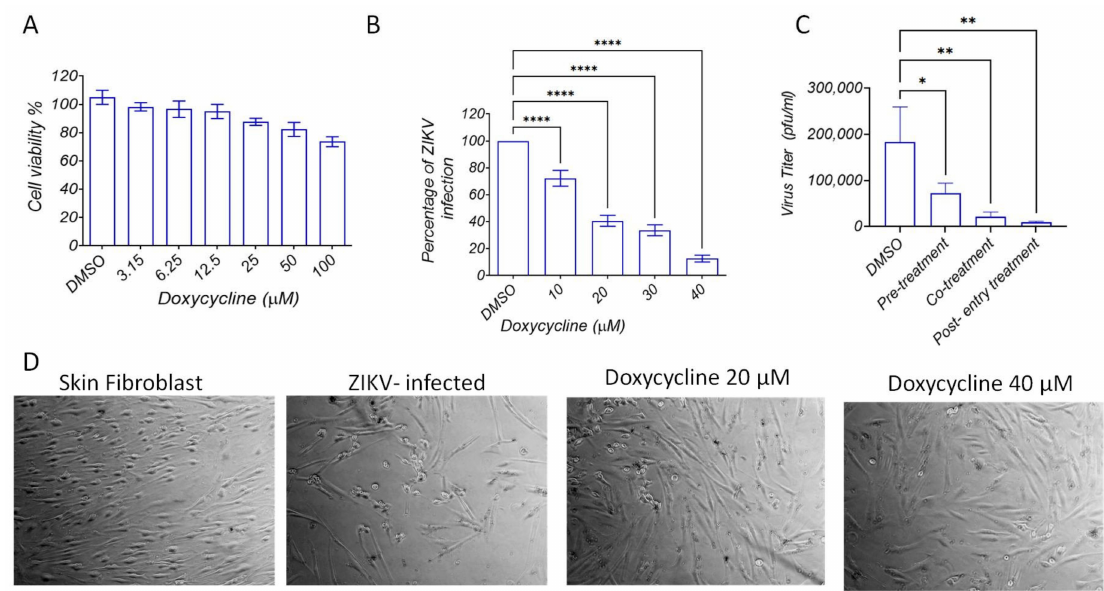
Figure 3. Inhibitory effects of doxycycline against virus replication in human skin fibroblast. ( A ) Cell viability were analyzed by Non-Radioactive Cell Proliferation kit (Promega, USA) according to the manufacturer’s protocols. ( B ) Skin fibroblasts were grown in a 24-well tissue culture plate for 24 h under optimal conditions. The cells were: infected with 0.1 MOI of ZIKV for 2 h, new media containing increasing concentrations of doxycycline were added and incubated for 48 h, and virus quantification was carried out by plaque formation assay using Vero cells. The virus replication was considerably reduced with increasing concentration of doxycycline. Approximately 50% virus reduction was observed at 20 µ M of doxycycline. ( C ) Time-of-addition assay showed the potent antiviral activity of doxycycline (40 µ M) at the post-entry treatment. ( D ) ZIKV-infection-induced cytopathic effects (CPE) on human skin cells. * p < 0.05, ** p < 0.001, **** p <